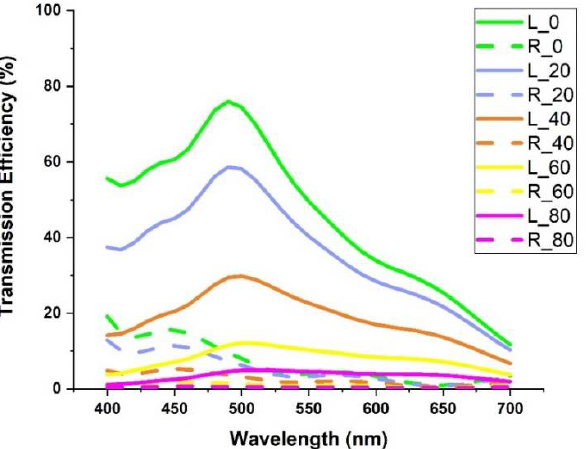
Figure 7. The transmission efficiency of LHDCP with incident LHP and RHP light vs. angle of incidence, varied in 20 ◦ steps from 0 ◦ to 80 ◦ . Solid lines are LHP and dotted lines are RHP.